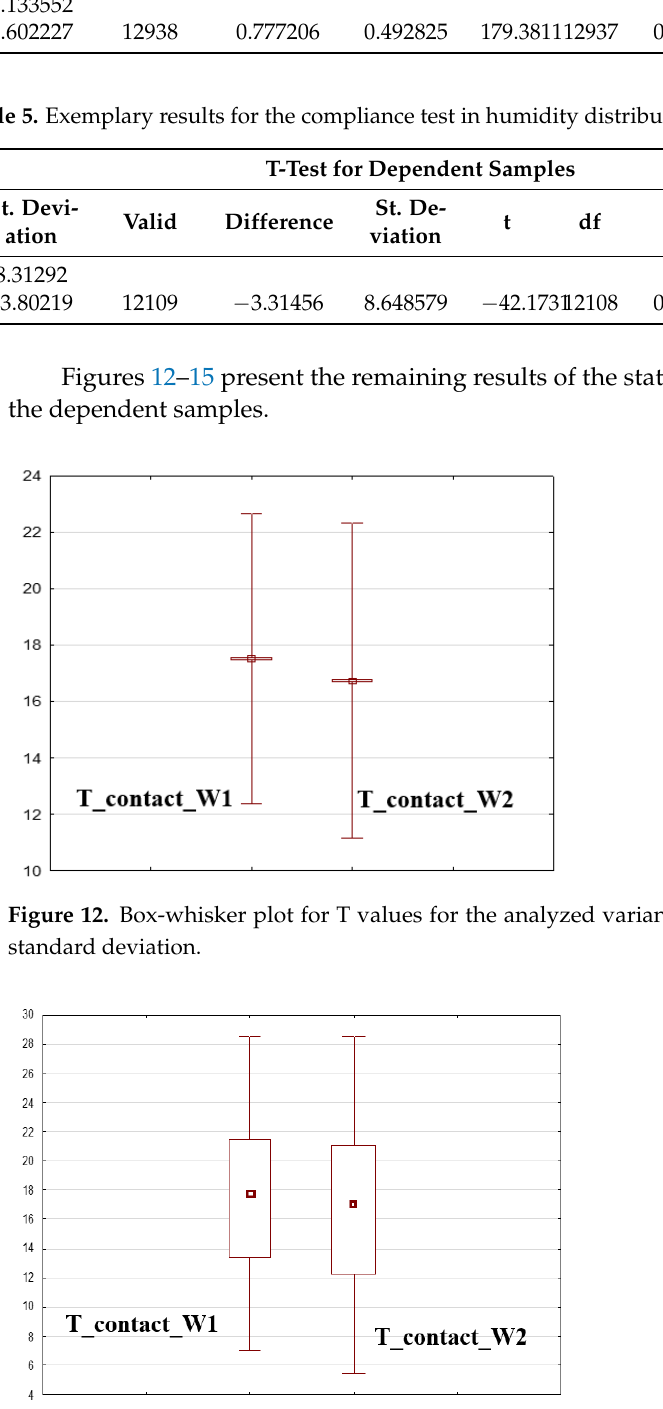
Figure 13. Box-whisker plot for T values for the analyzed variants: median; 25–75%; Min-max.